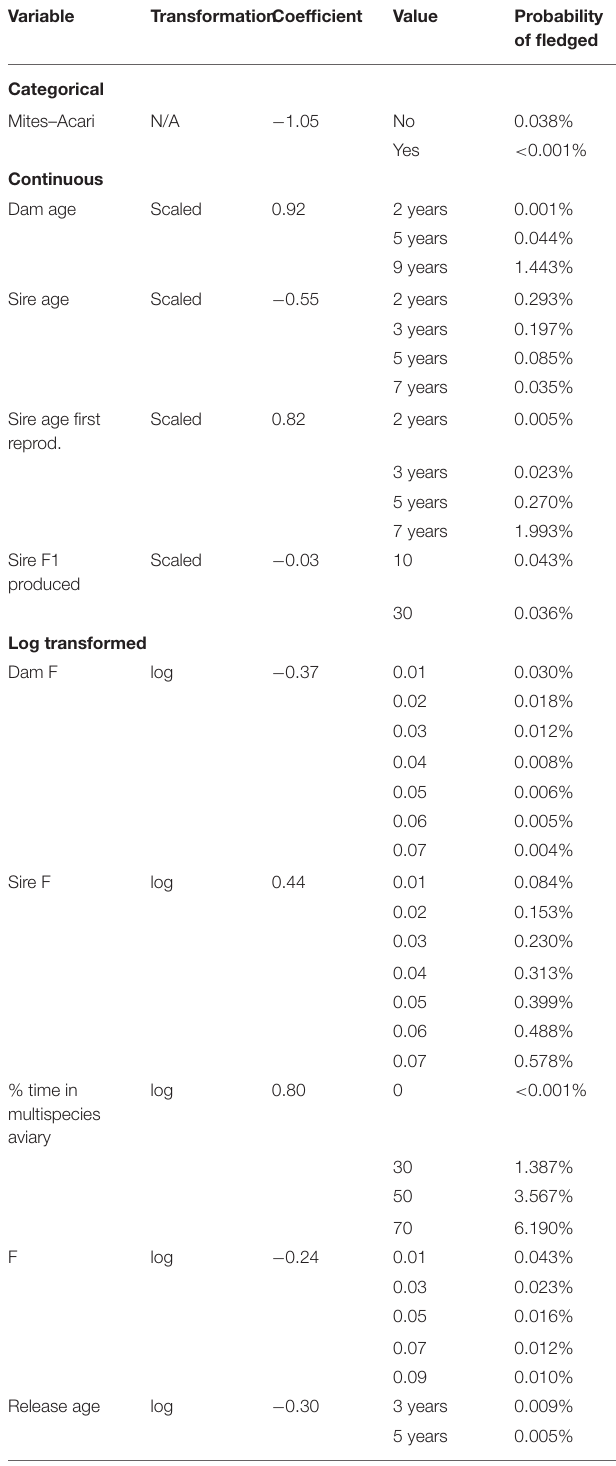
TABLE 4 | Output from ordinal regression model for (transformed) variables for the subset of males resighted during the male breeding season. Variable